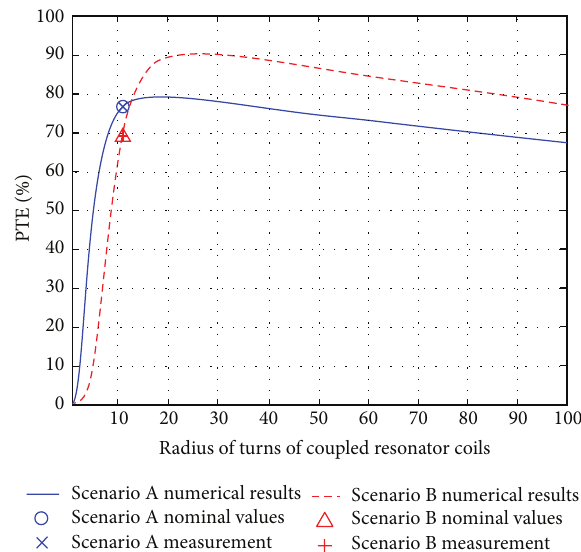
Figure 4: PTE versus number of turns of coupled resonator coils for two different DCR configuration scenarios.